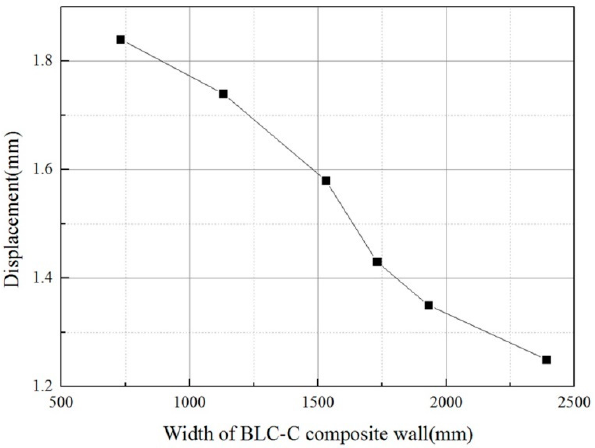
Figure 12. Variation curve of the horizontal displacement at the initial cracking of the interface with the width of BLC-C composite wall.